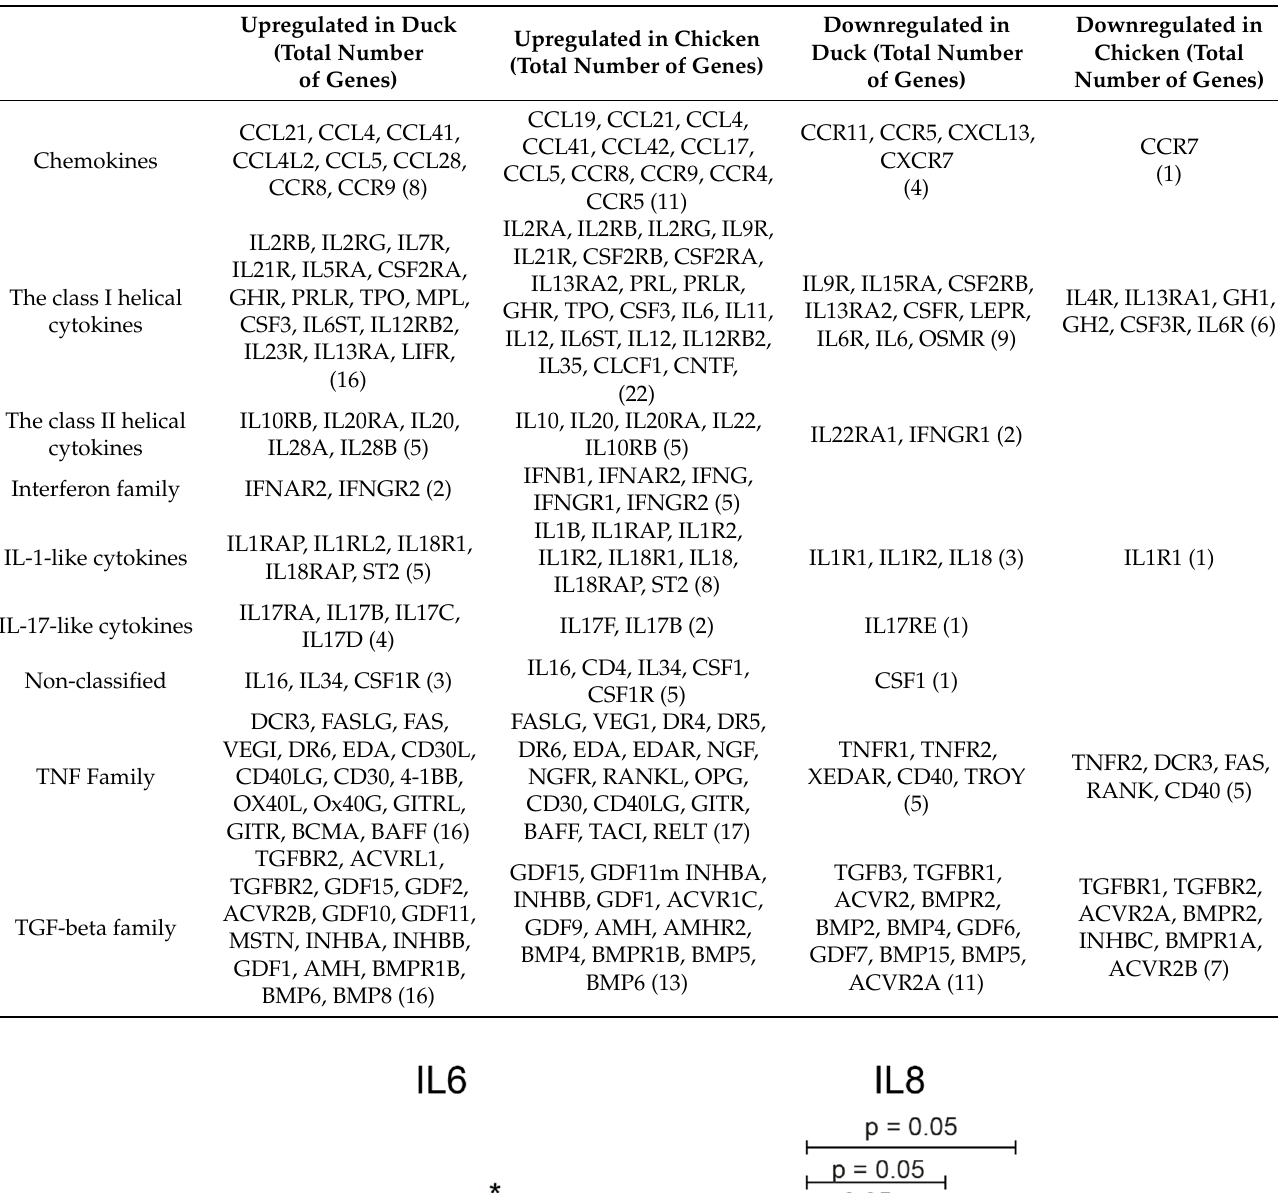
Table 1. Cytokine–cytokine interaction pathways in chickens and ducks.